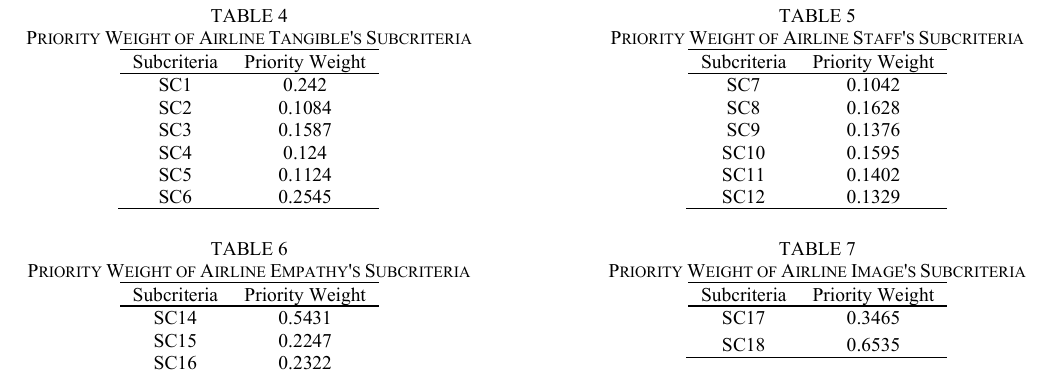
TABLE 7 P RIORITY W EIGHT OF A IRLINE I MAGE ' S S UBCRITERIA